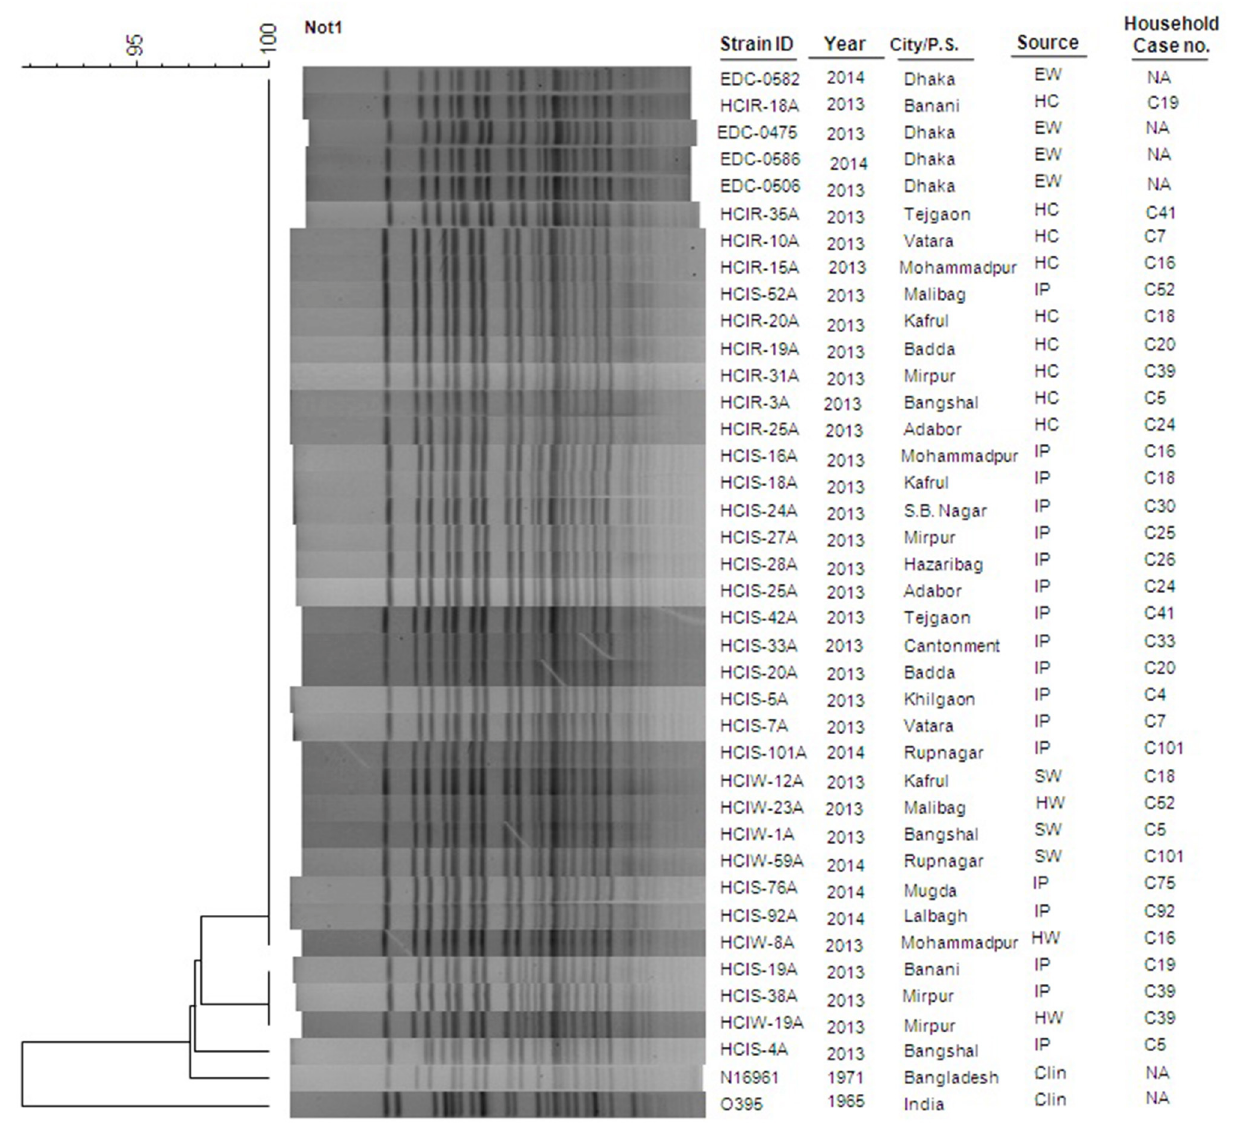
FIGURE 2 | Genetic Characterization using PGFE of water and clinical V. cholerae O1 strains collected in the households of cholera patients. Thirty seven V. cholerae O1 strains were isolated in Dhaka city from hospitalized cholera patients ( n = 18), their household contacts ( n = 9), drinking water sources ( n = 6) and environmental water ( n = 4) from waterbodies circulating around the city. The dendrogram was constructed by Dice similarity coefficient and mainstream hierarchical clustering (UPGMA) using PFGE images of Not 1-digested genomic DNA. The scale bar at the top left indicates the similarity coefficient (range: 90–100%). IP, Index Patient; HC, Household contact; EW, Environmental Water; SW, Source Water; HW, House-hold Water; Clin, Clinical; NA, Not